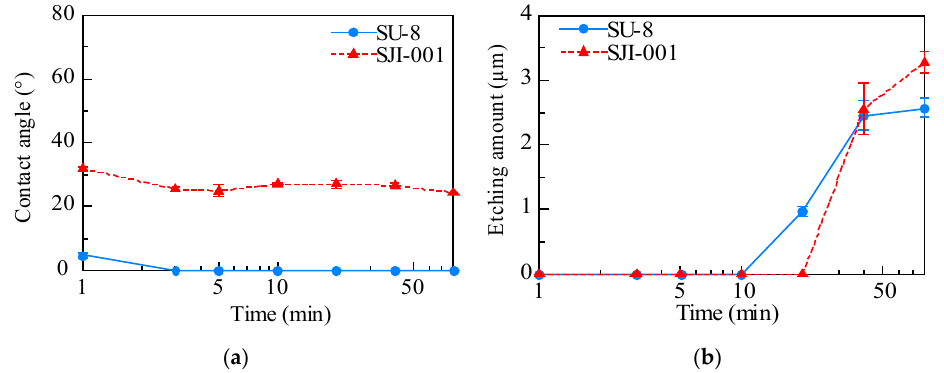
Figure 3. The effect of plasma treatment on SJI-001 and SU-8. The contact angle of both materials was decreased. Although the contact angle of SU-8 was decreased to lower than 5°, the contact angle of SJI-001 stopped declining around 25° ( a ). The etching speed of both materials decreased after 40 min of plasma treatment ( b ).